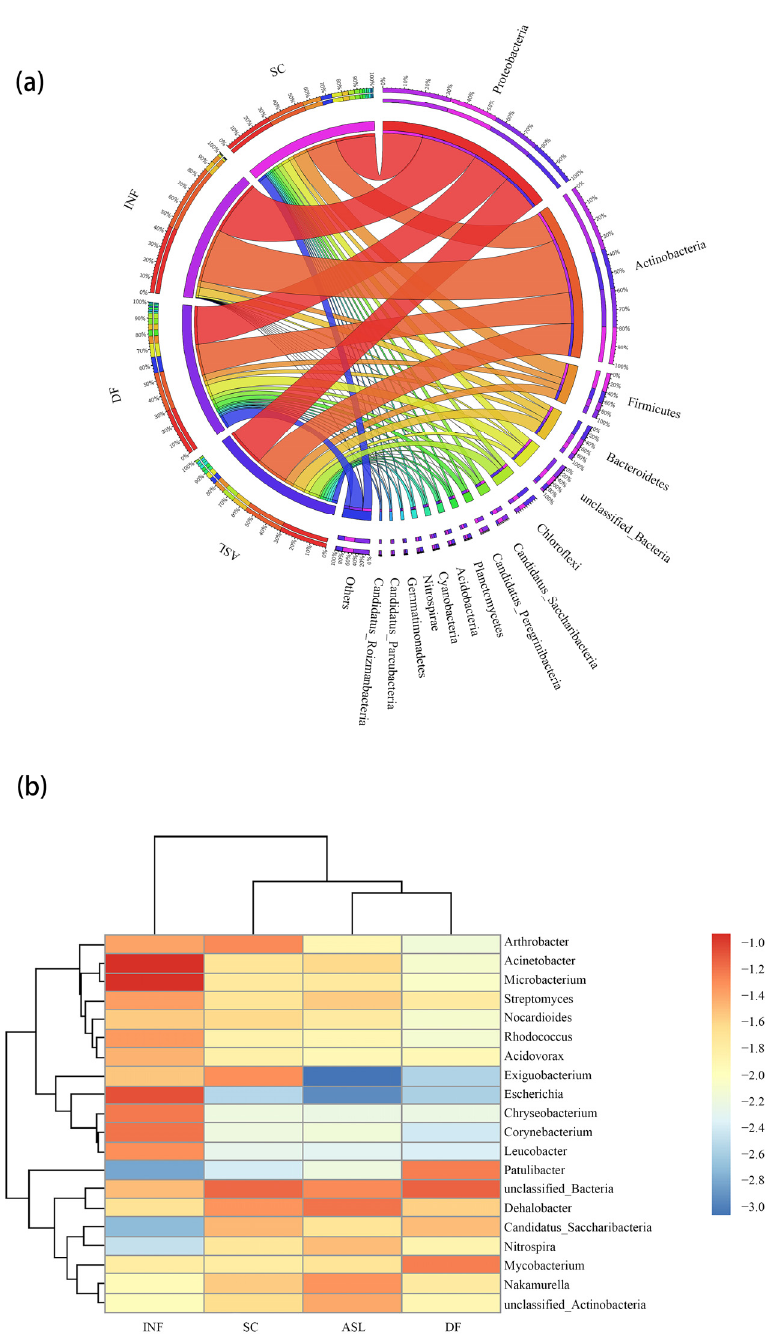
Figure 1. Distribution of bacterial communities in wastewater. ( a ) Circular representation of the bacterial community in INF, ASL, SC, and DF at phylum level. The outermost circles are names of sample and microbial. The lines inside the circle connect the genus to the sample and these lines stand for the relative abundance of different genera in the samples; ( b ) the top 20 abundant bacteria at genus level are based on the RPKM method (the color bar indicates log 10 transformed values of relative abundance).